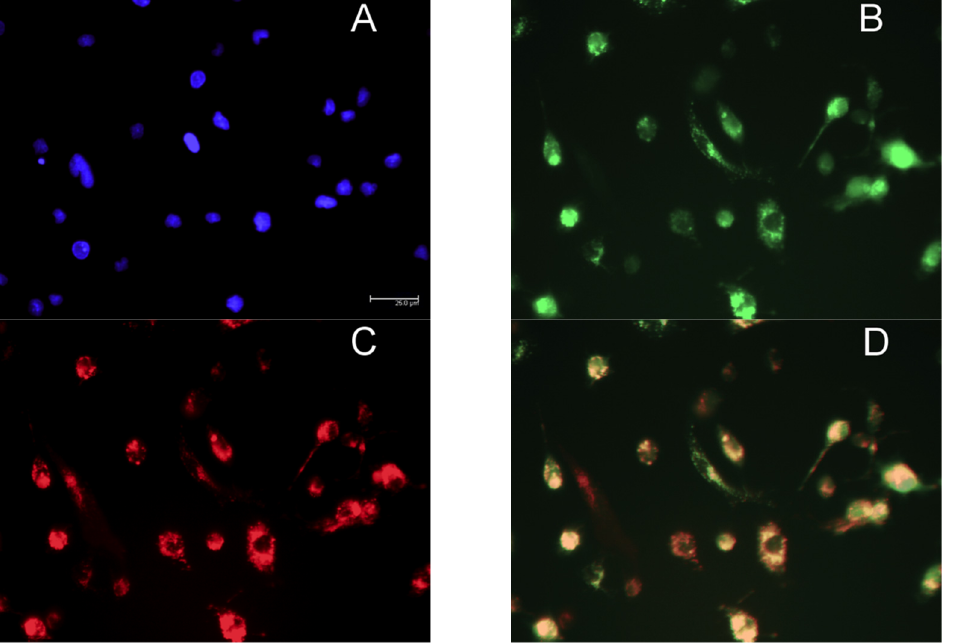
Figure 4. Fluorescence microscopy images showing co-localization of FITC-labeled mannosylated ligand with the fluid endocytosis marker rhodamine-dextran. Rat M2 MPs were incubated with culture medium containing the nuclear dye DAPI, 120 nM FITC-labeled MRTL and 5 µM of the general fluid endocytosis marker rhodamine-dextran, for 1 h. Cells were washed with PBS buffer and acid wash solution and analyzed by fluorescent microscopy using a light filter for DAPI (( A ) blue), FITC (( B ) green) and rhodamine-dextran (( C ) red). The three-color merged image ( D ) shows that the green and red fluorescence are largely co-localized, resulting in an orange color. This suggests that the free MRTL is internalized and situated mainly in endocytosed vesicles.